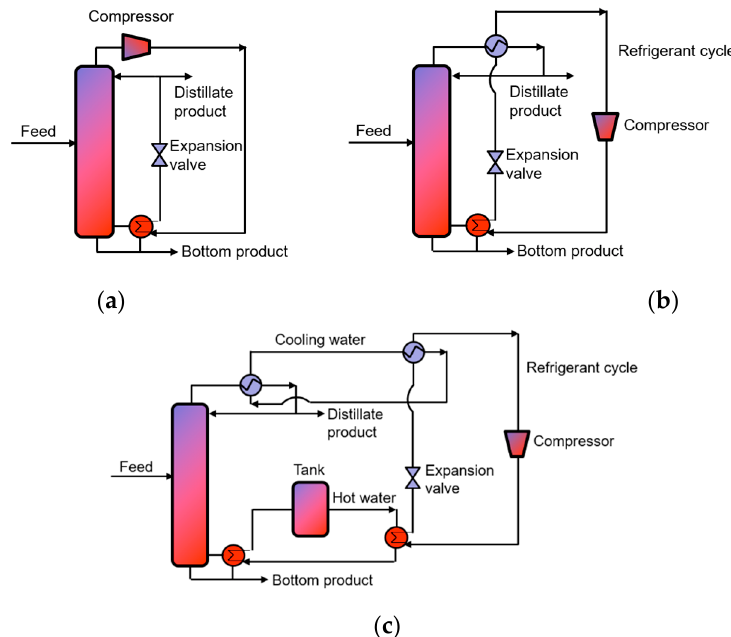
Figure 1. Schematic of the heat pump systems: ( a ) mechanical vapor recompression heat pump, ( b ) vapor recompression heat pump, and ( c ) new heat pump